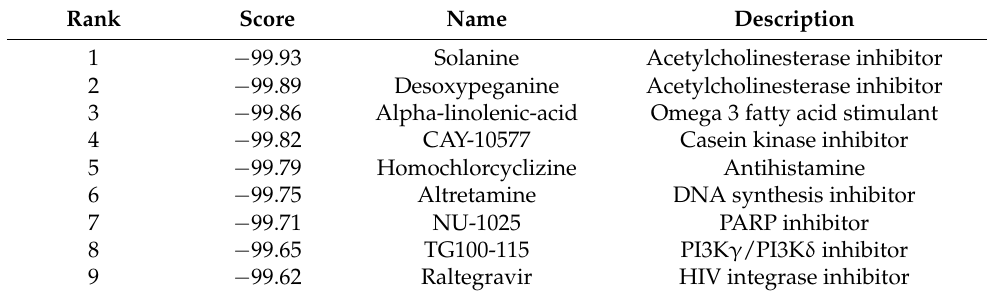
Table 3. Small molecules predicted with the common shared hub